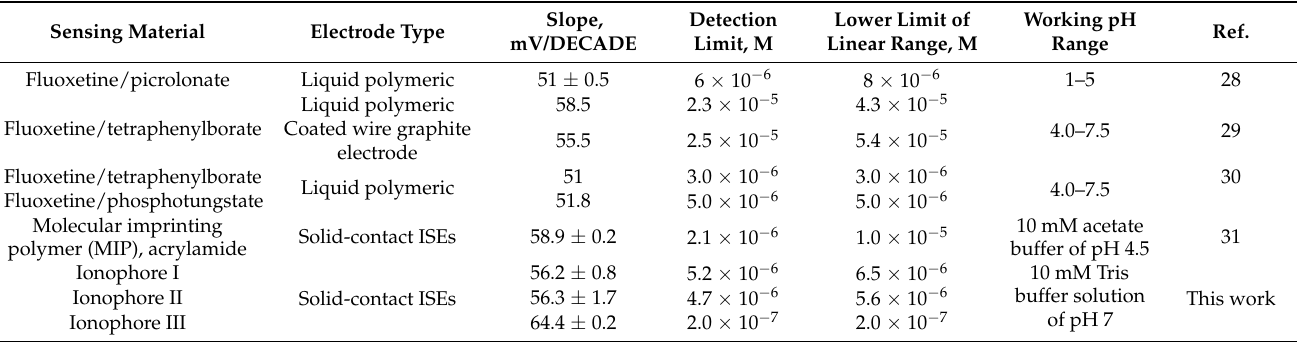
Table 1. Comparison of the presented sensors with previously reported potentiometric ion-selective electrodes